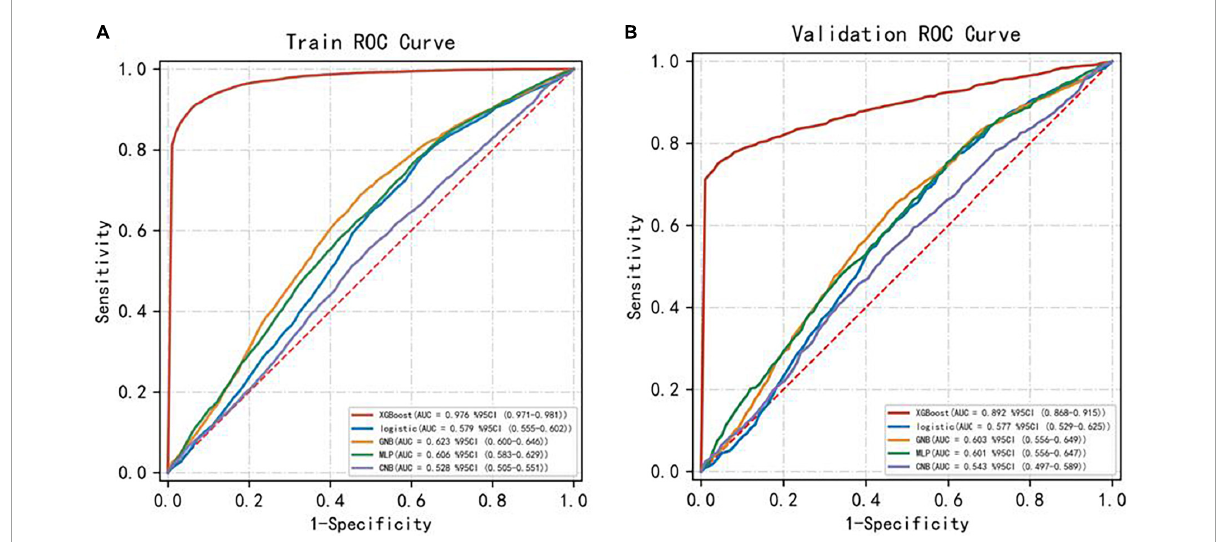
FIGURE5 AUC for the five ML models. Panel (A) represents the training dataset ROC curve and panel (B) represents the test dataset ROC curve.